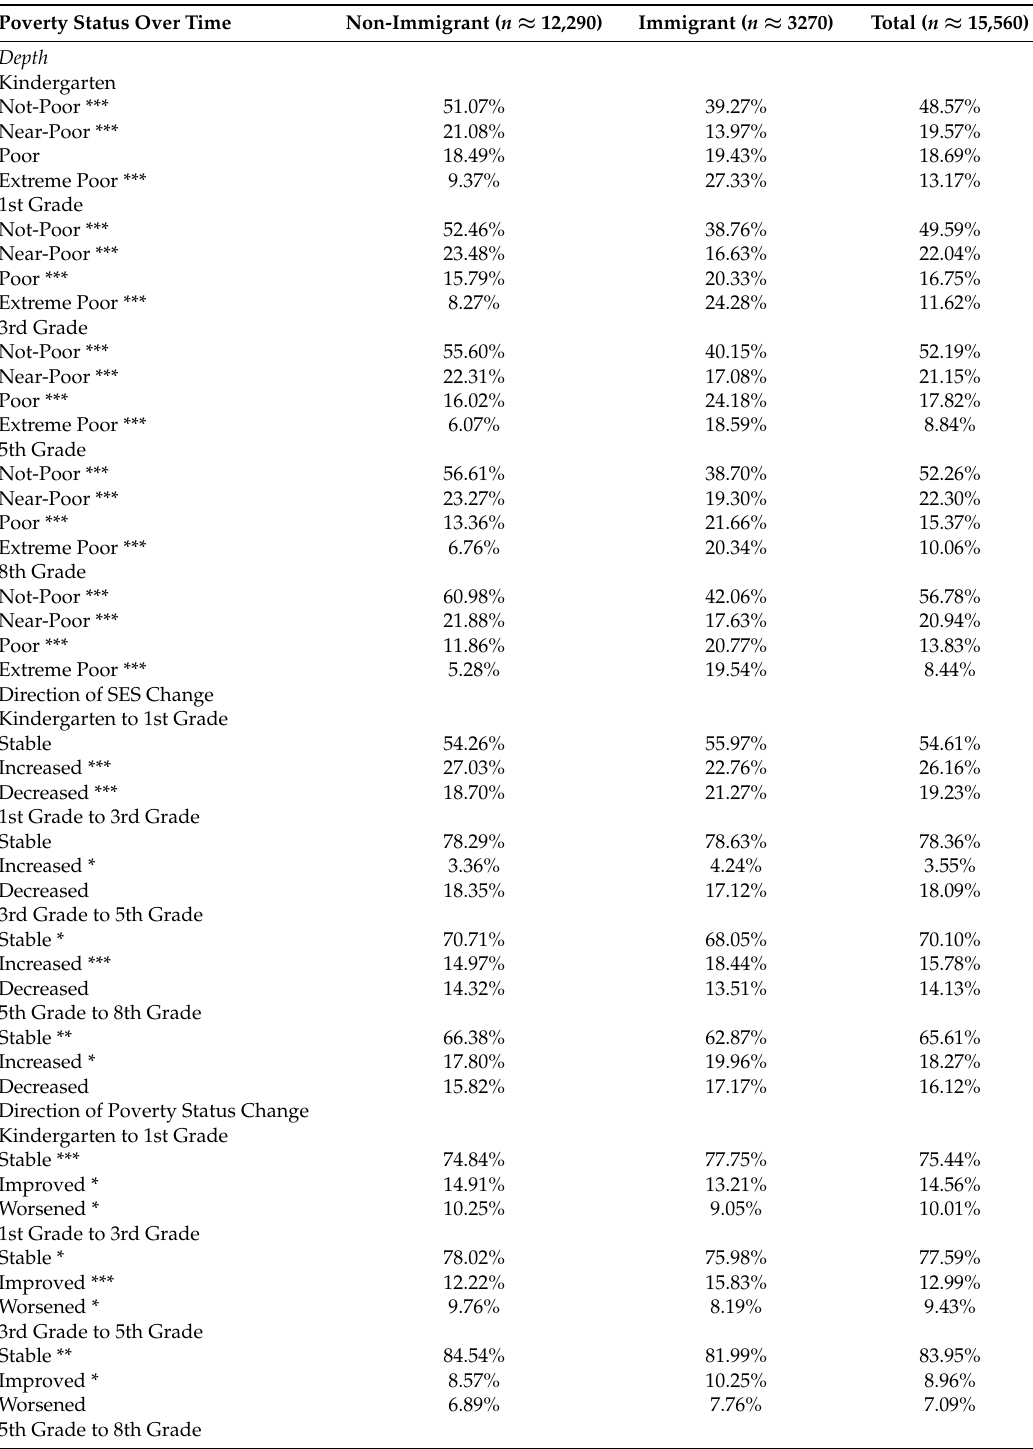
Table 2. Sample size and percentage distribution of poverty DYNAMICS by immigrant status from kindergarten to eighth